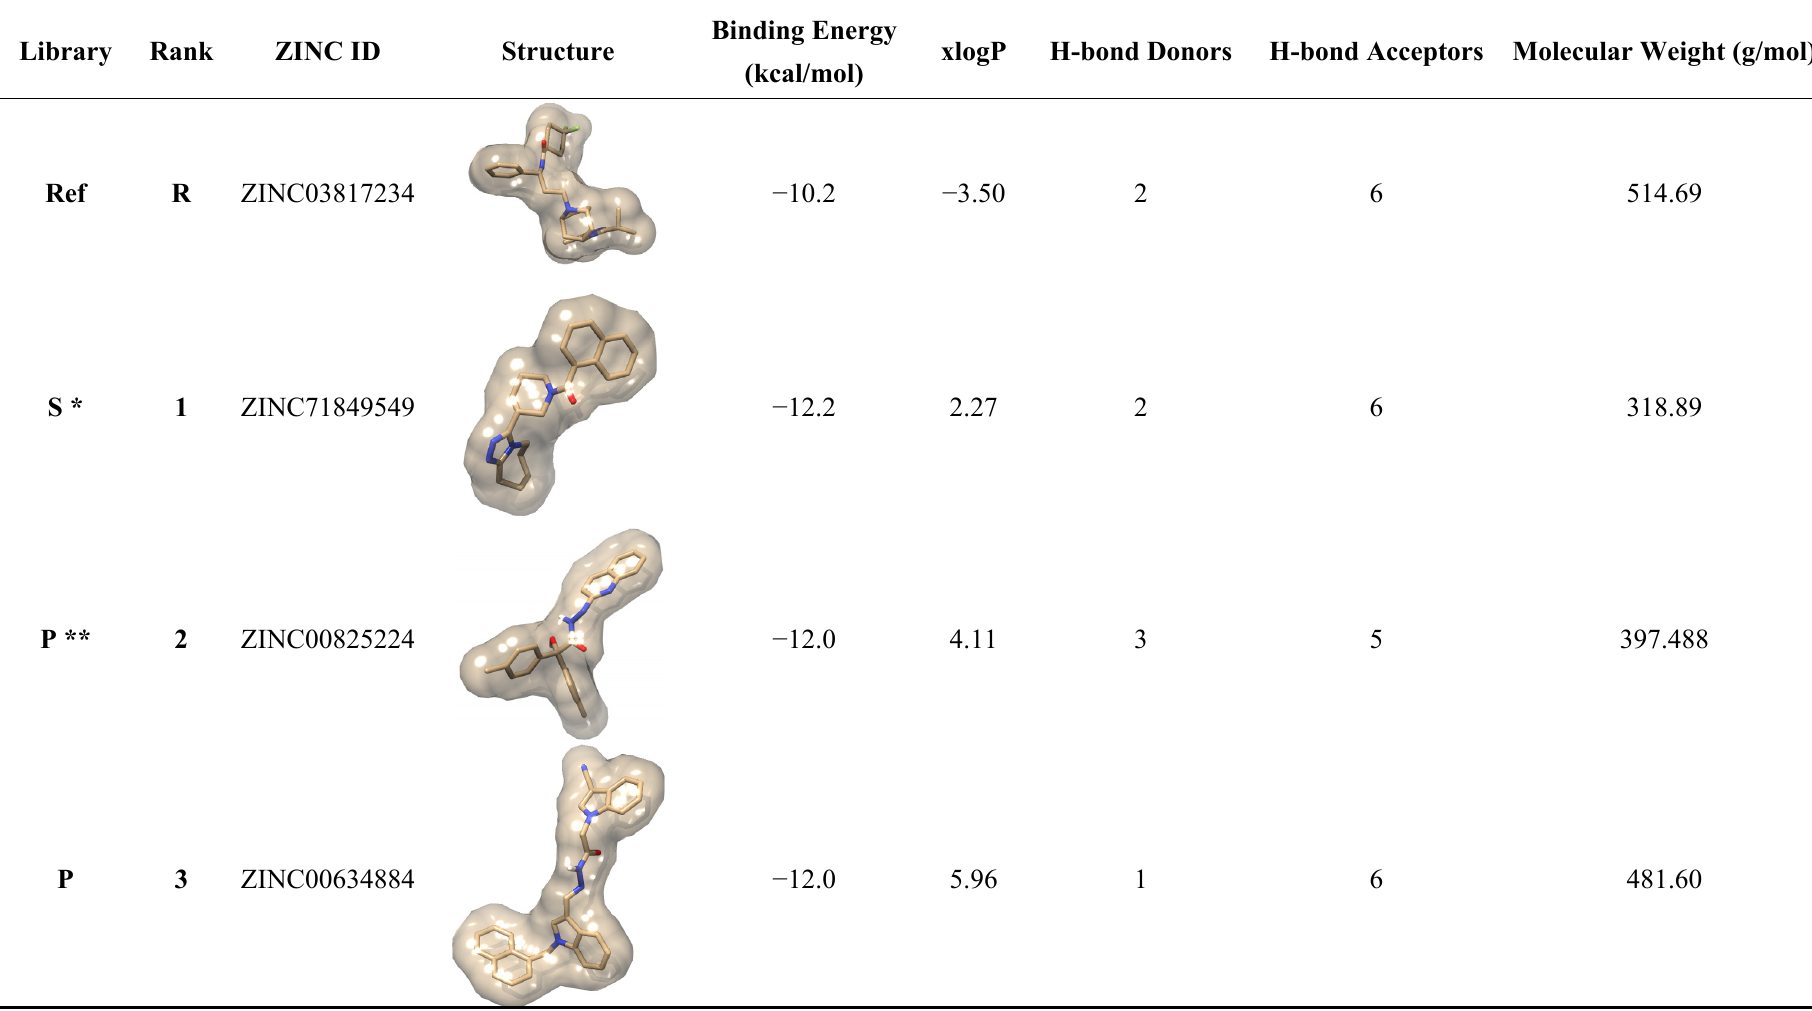
Table 3. List of the top 10 screened compounds based on their docked binding energy. Compounds are ranked in order of highest to lowest binding